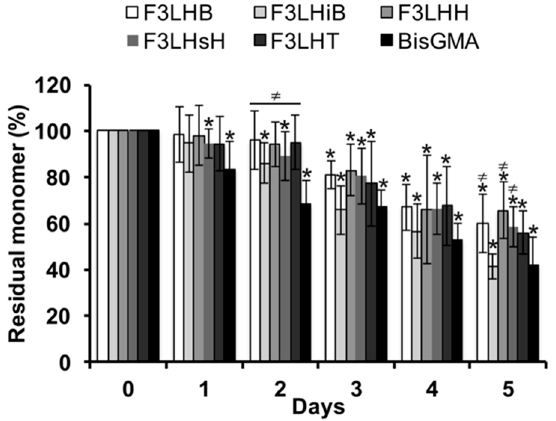
Figure 2. Monomer Degradation. Residual monomer in the biodegradation solution incubated with 0.35 g · L − 1 HSA at pH 8.8 ( n = 9, ± standard deviation (SD)). * Denotes significant difference ( p < 0.05) from Day 0. For a given time point, (cid:3405) denotes significant difference ( p < 0.05) from BisGMA.